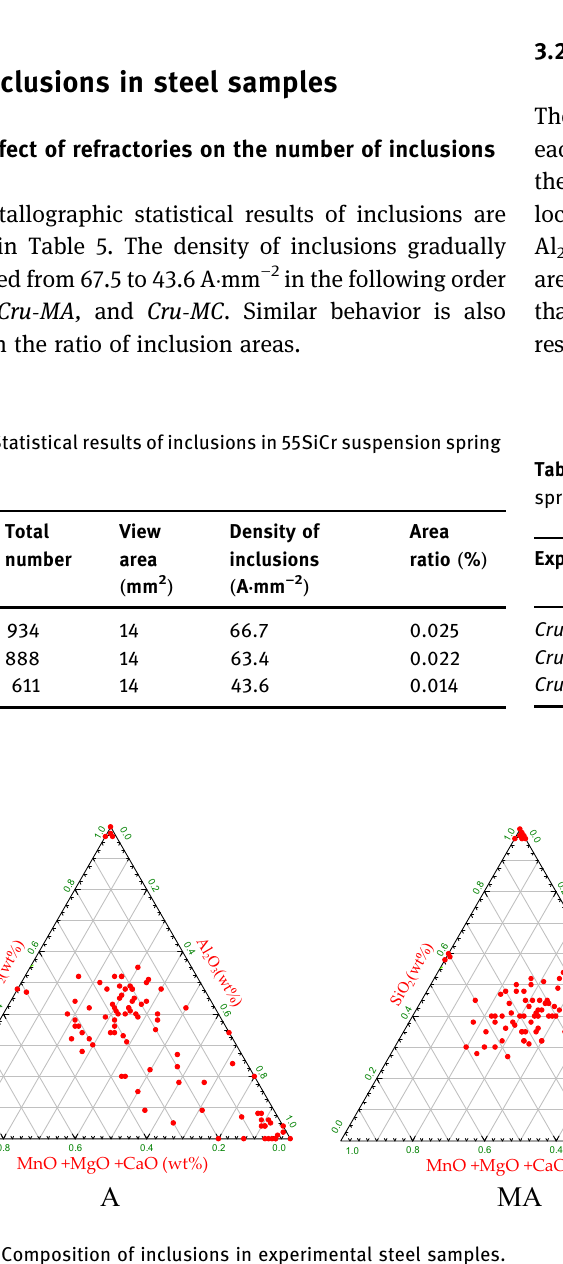
Figure 3: Composition of inclusions in experimental steel